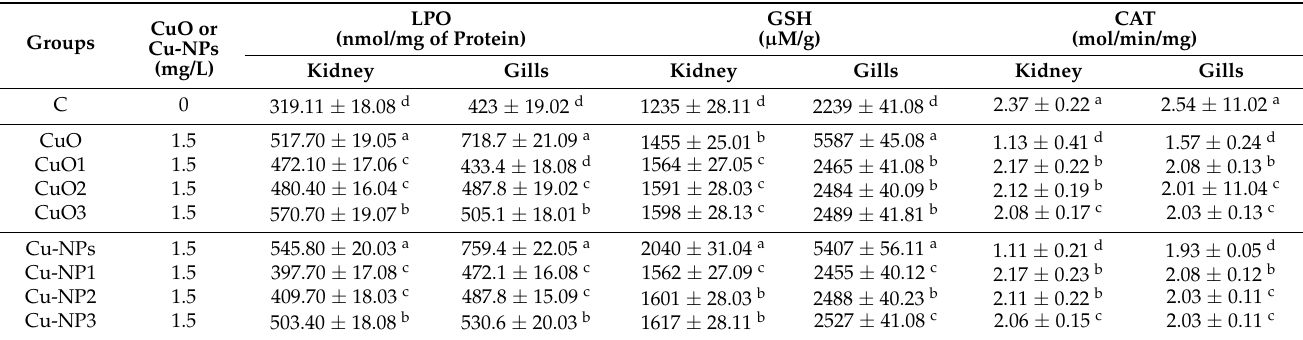
Table 6. Concentration of oxidative stress enzymes (mean ± SE) measured in gills and kidney of the common carp C. carpio experimentally treated with 1.5 mg/L of CuO or Cu-NPs alone, and with different doses of MSFE, besides the control group (C). Means with different superscripts (a, b, c, d) presented significant differences. (LPO: lipid peroxidation; GSH: glutathione; CAT: catalase).